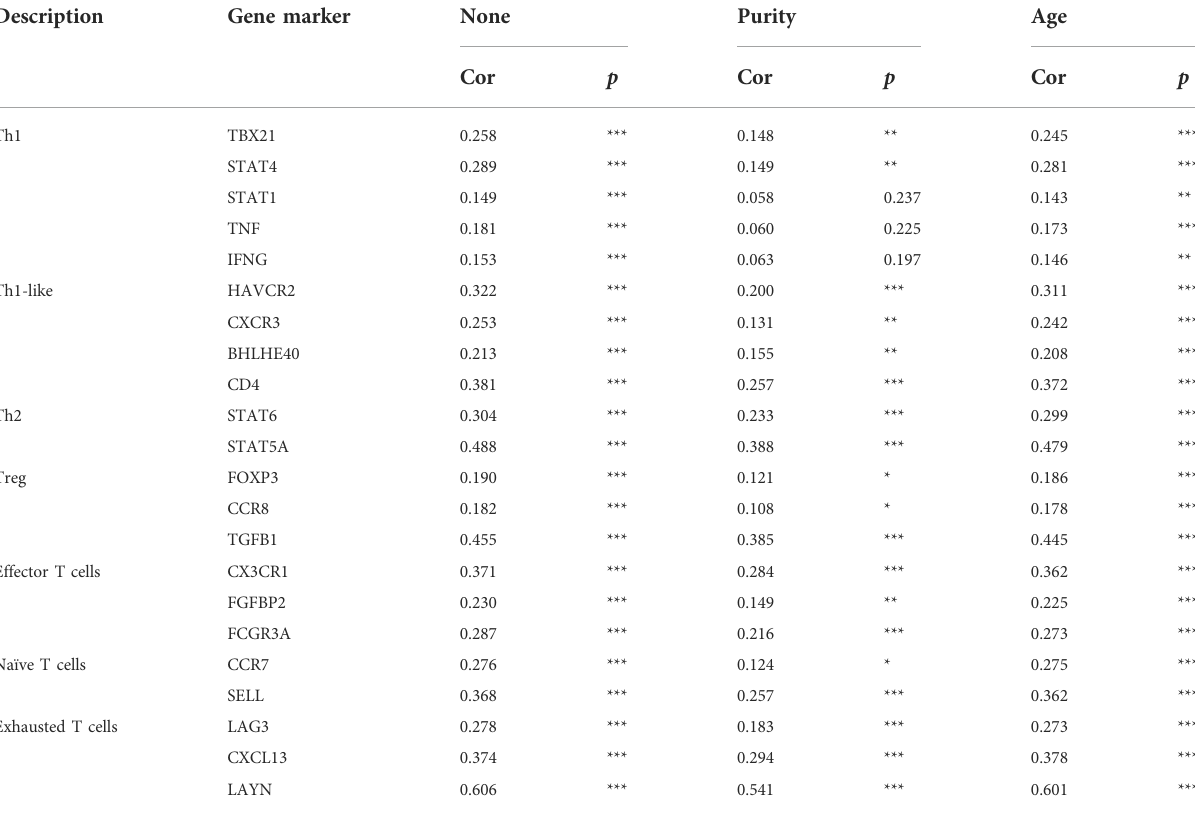
TABLE 2 Correlation analysis between LMO3 and gene markers of different types of T cells in TIMER.